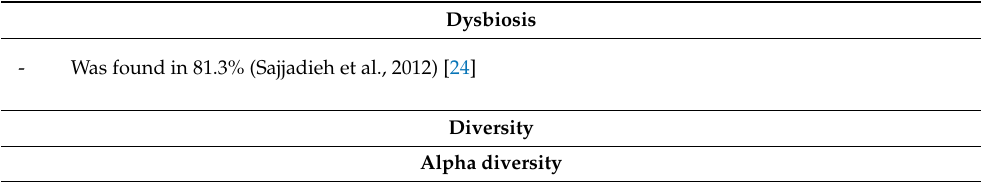
Table 7. Key findings from selected